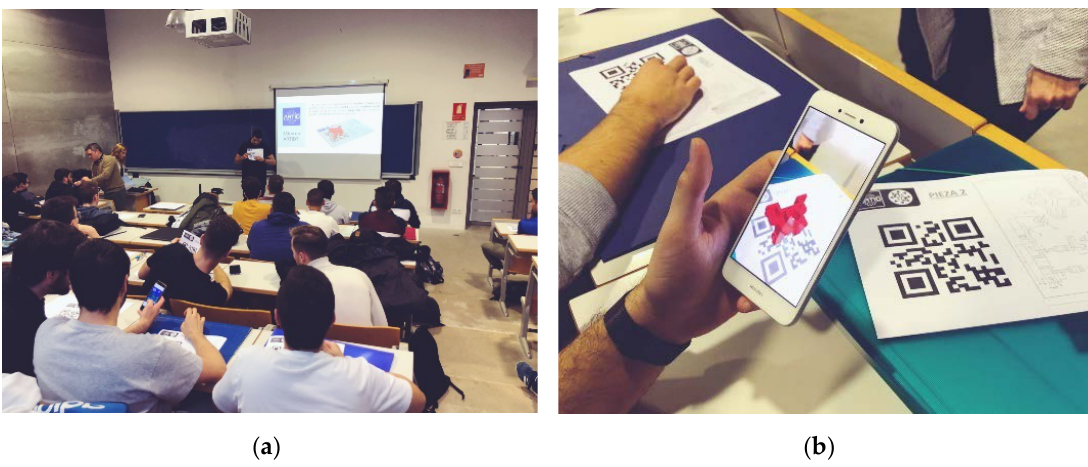
Figure 8. a) Photograph of the class where the test was performed, b) one student capturing the QR code during the test.